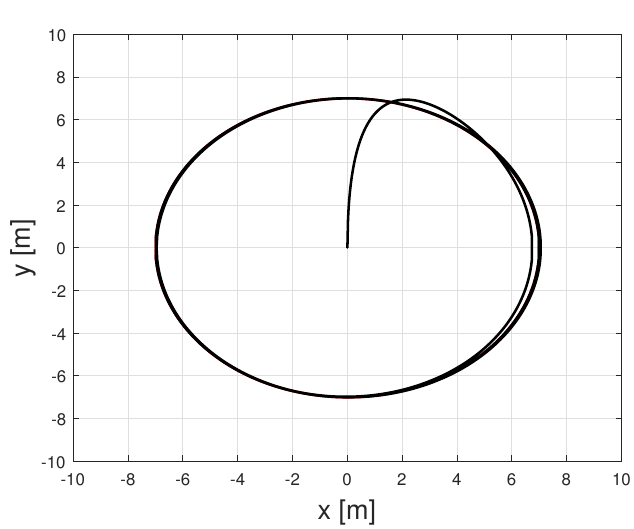
Figure 2. UGV circle trajectory